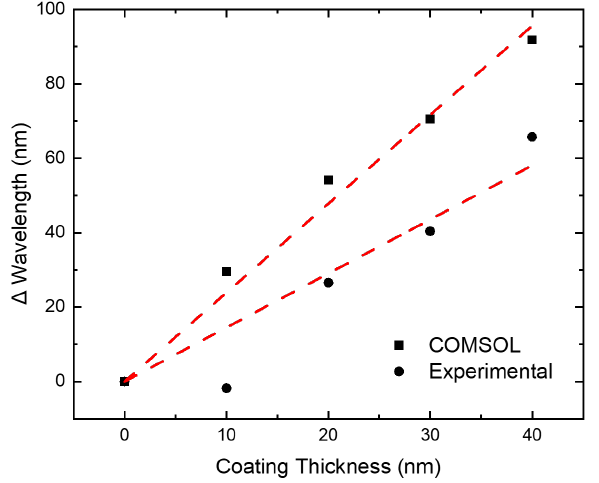
Figure 6. Experimental results delineating the effects of incremental conformal coatings of amorphous Al 2 O 3 deposited on reciprocal plasmonic metasurfaces. The main absorption peak represented in Figure 4 at 4.8 µm red-shifts after 10 nm